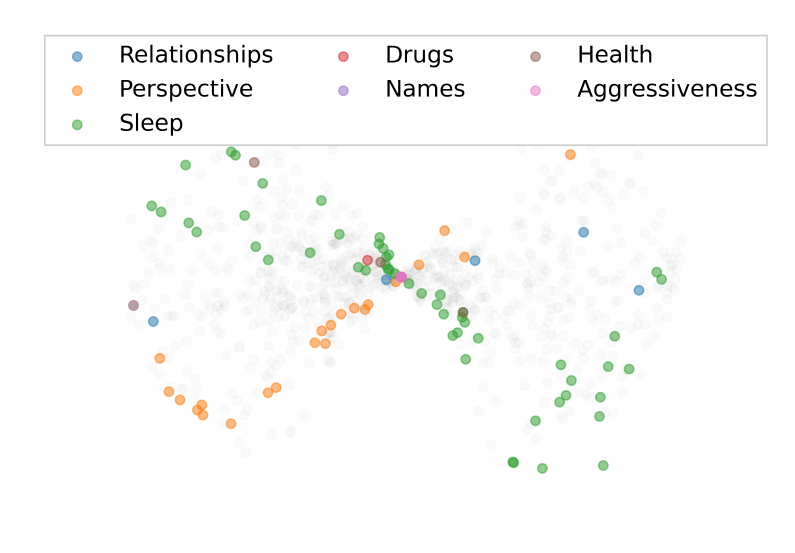
Figure 9. Bidimensional reduction of the points R ( w ) in each cluster of D , using PCA. The gray points are the rest of the words in the